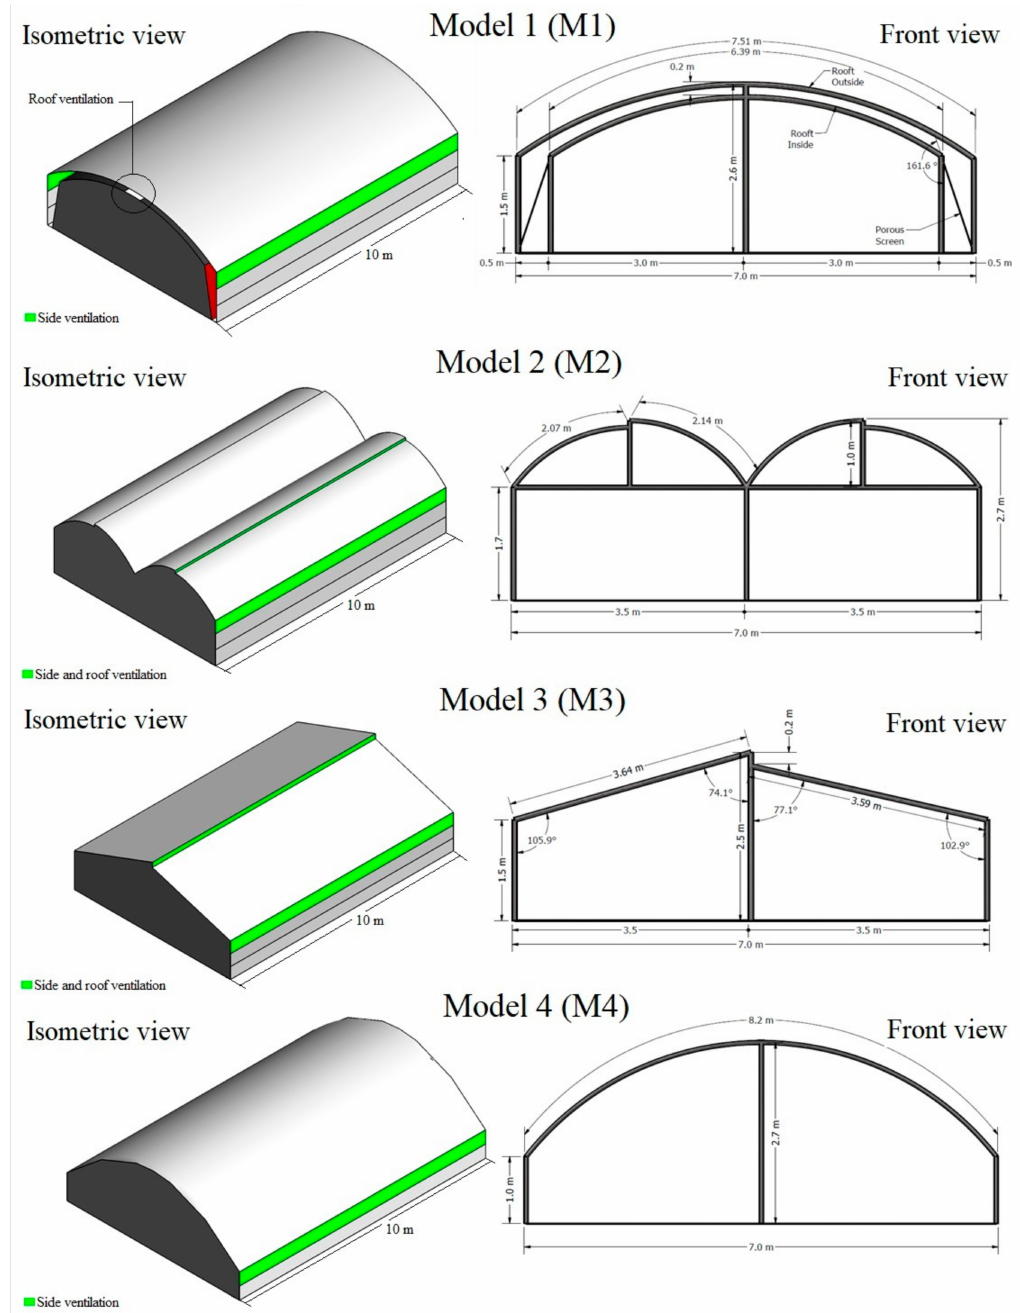
Figure 1. Architectural characteristics of the dryers